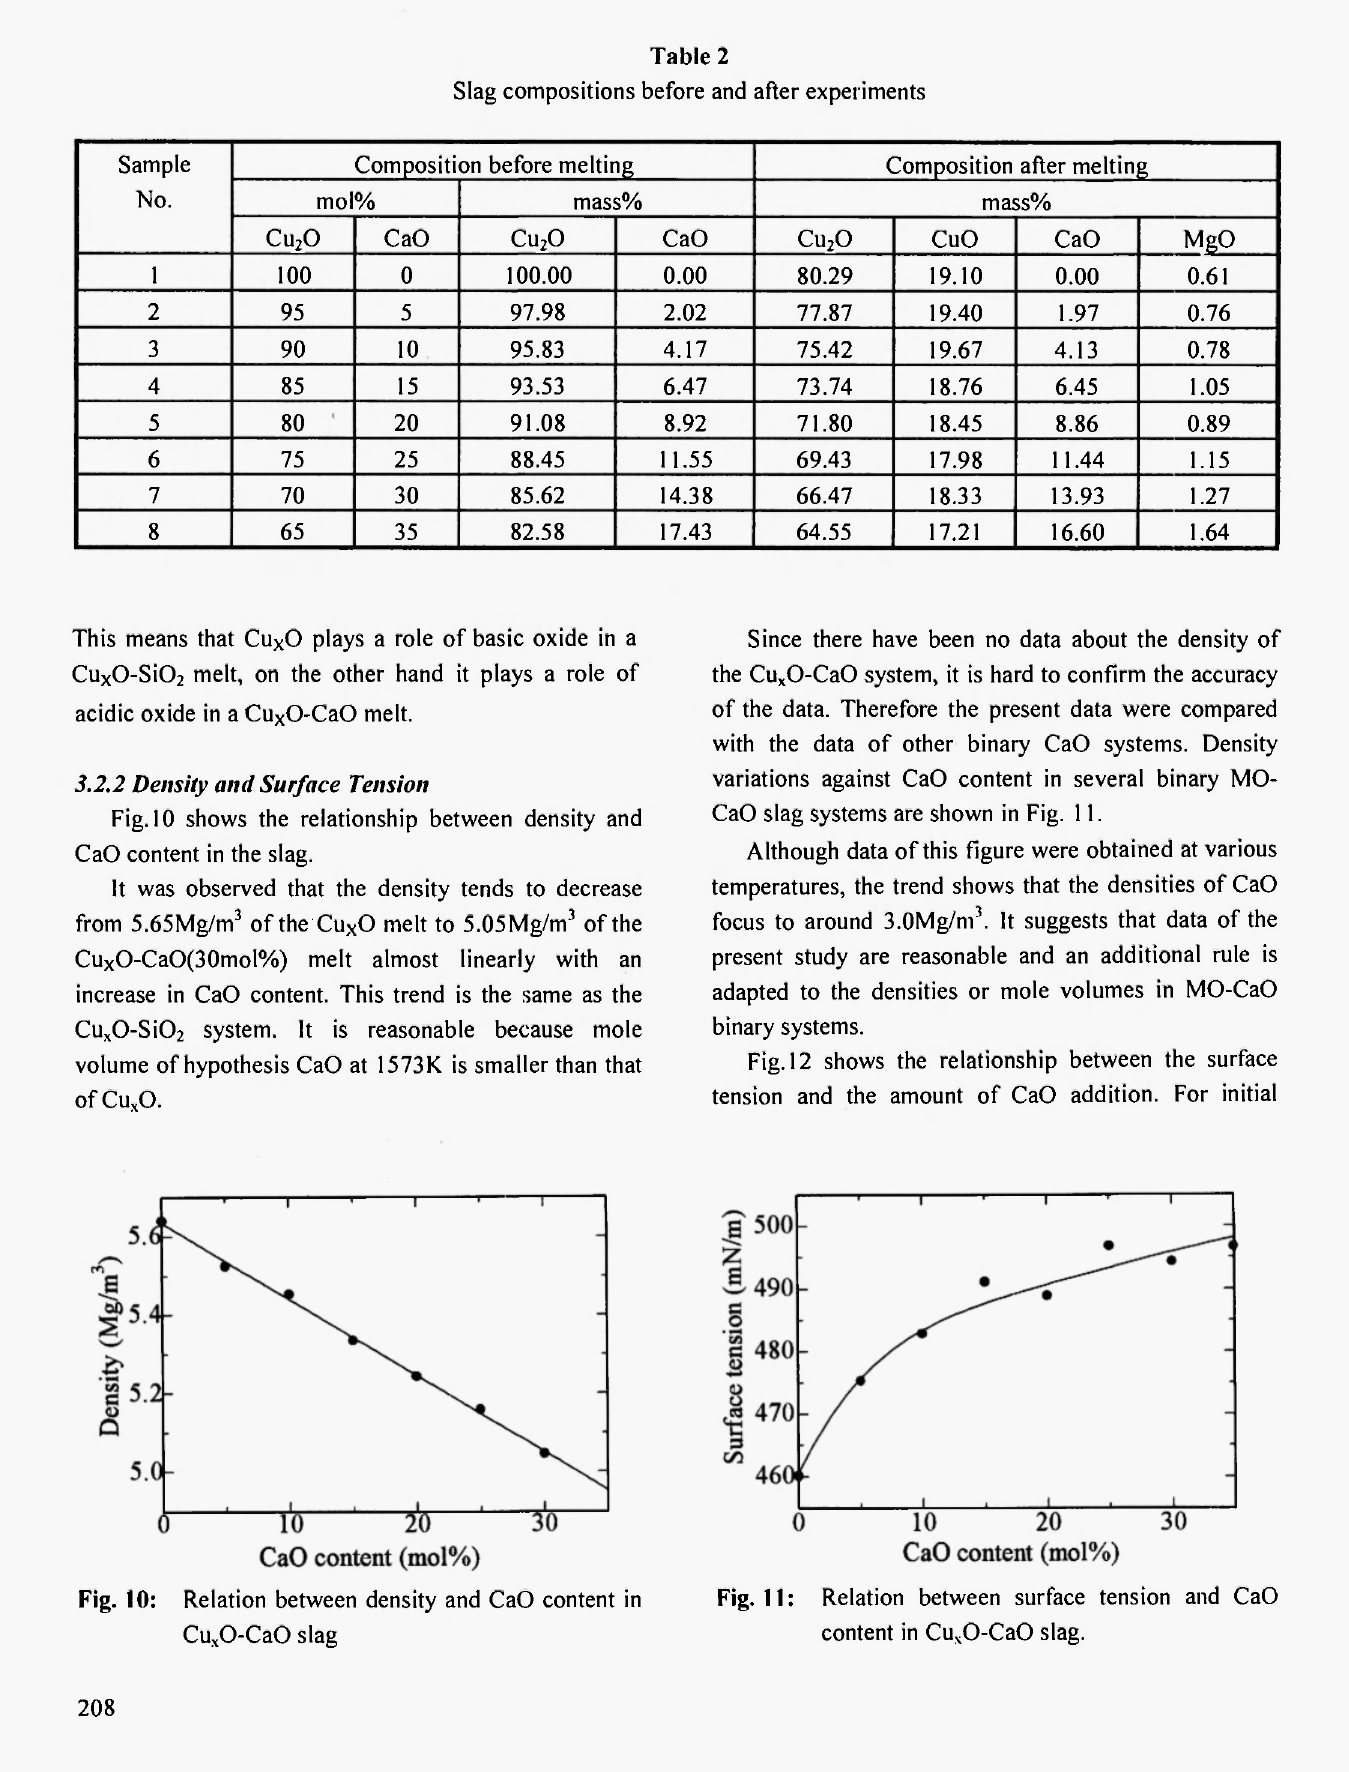
Relation between surface tension and CaO content in Cu x O-CaO